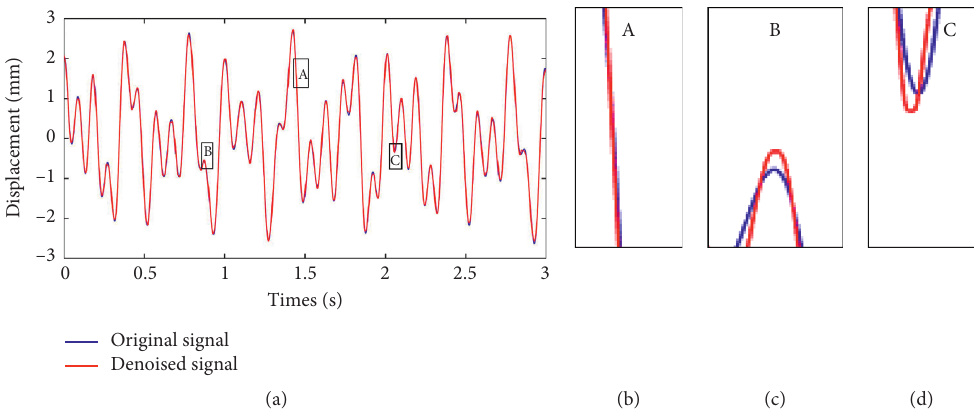
Figure 4: Curve comparison between S ( t ) and X ( t ) . (a) Curve comparison between the original signal X ( t ) and the denoised signal using the MF-ESMD method, (b) enlarged figure of area A in (a), (c) enlarged figure of area B in (a), and (d) enlarged figure of area C in (a).